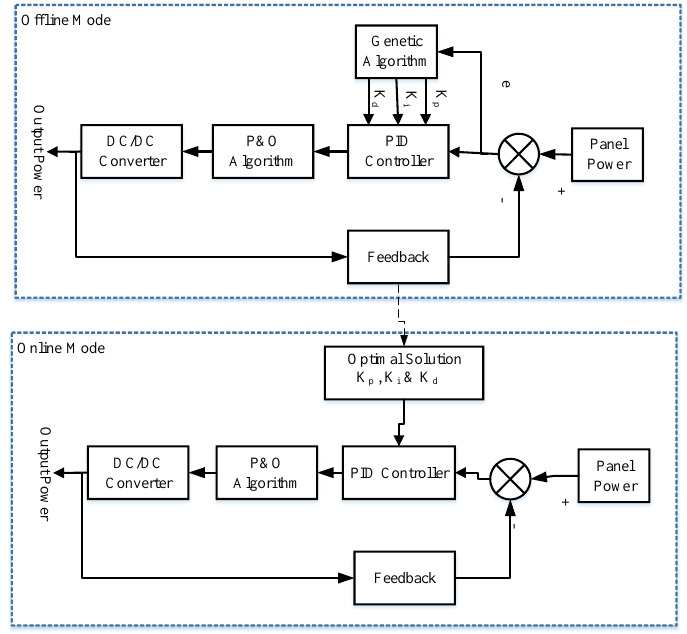
Figure 10. Offline and online mode of the controller [106].